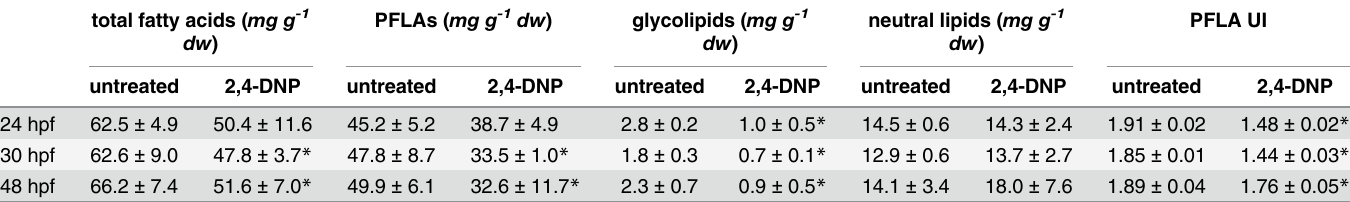
Table 2. Mean values ( ± STD) for contents of total fatty acids and lipid fractions as well as unsaturation indices (UI) of the PLFA fraction in untreated zebrafish eggs and eggs treated with 2,4-DNP at 24, 30 and 48 hpf. Values for 2,4-DNP treated eggs that were statistically significantly differ- ent from those for untreated eggs at the respective stage are marked with * (p < 0.05; Student ’ s t-test). Note that values for untreated eggs correspond to respective data presented in Fig 2 and are listed here for comparison. n = 3 – 4, with 50 eggs per n; hpf: hours post fertilization. total fatty acids ( mg g -1 dw